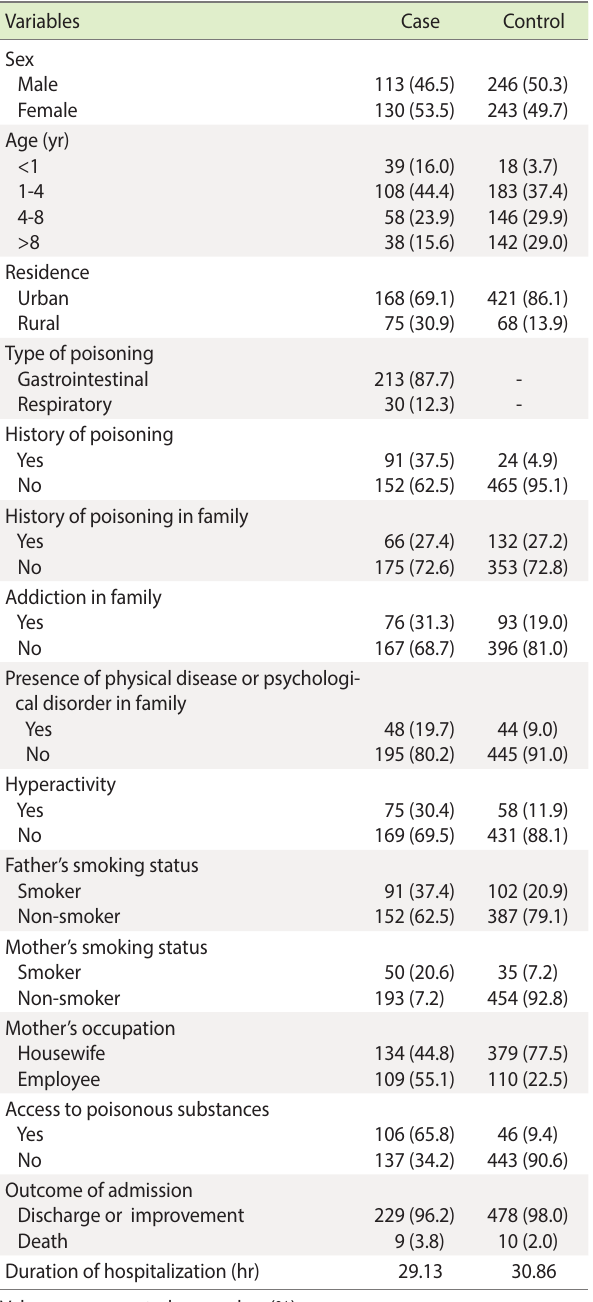
Table 1. Demographic and background information of the